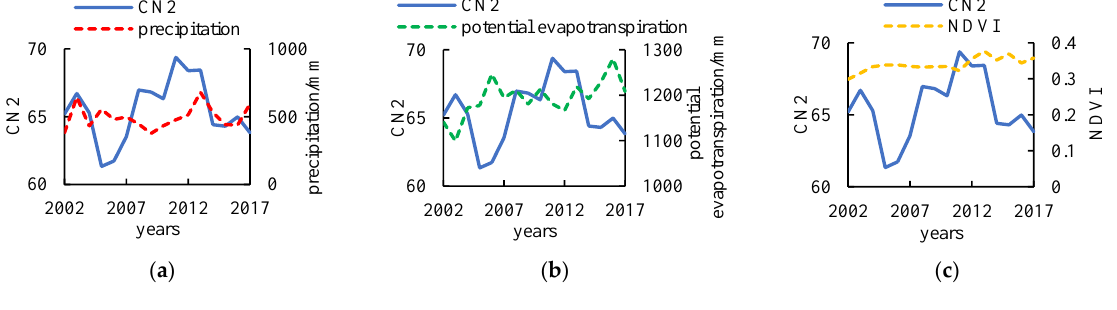
Figure 7. Time-varying process of CN2 to precipitation, potential evapotranspiration and NDVI. ( a ) Precipitation, ( b ) potential evapotranspiration, ( c ) NDVI.